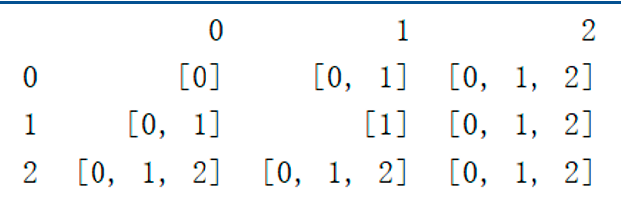
Figure 9. ( C , ▴ ) (running result of Python).